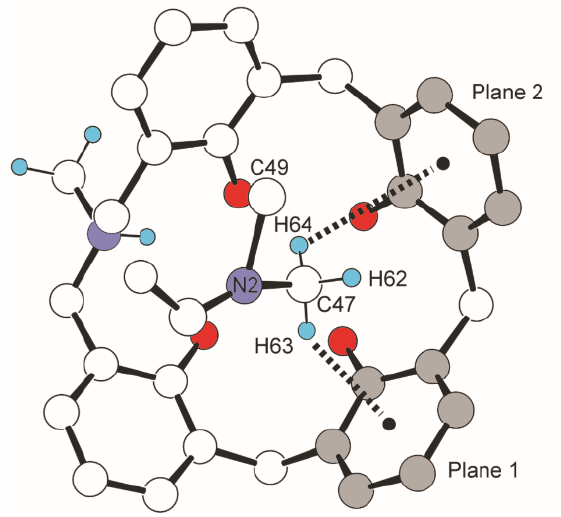
Figure 13. Structure of DMF ⊂ p - tert -butyl- N -Me-azacalix[3.1.1.1]arene and CH ··· π interaction in the inclusion compounds. Protons, except H62, H63, H64, NH + -CH 3 , and tert -butyl group, were omitted for clarity.